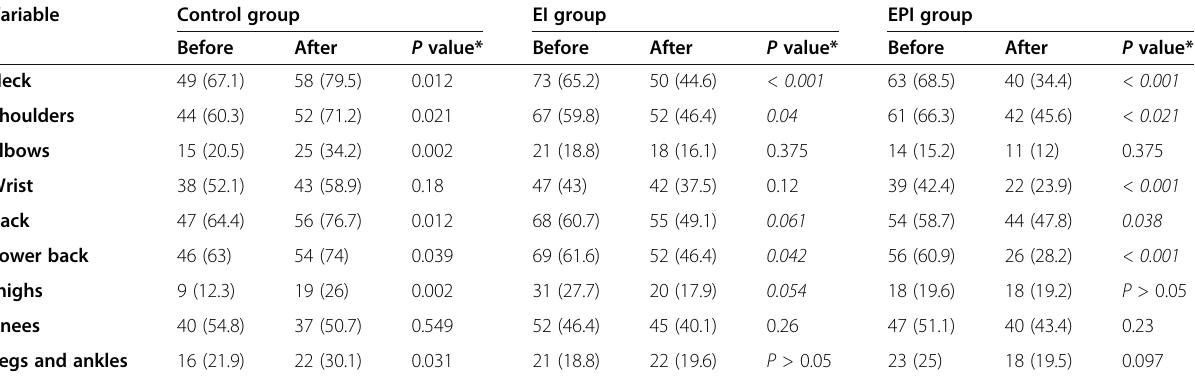
Table 3 Comparative results of prevalence of musculoskeletal disorders in different areas of body in three groups before and after intervention